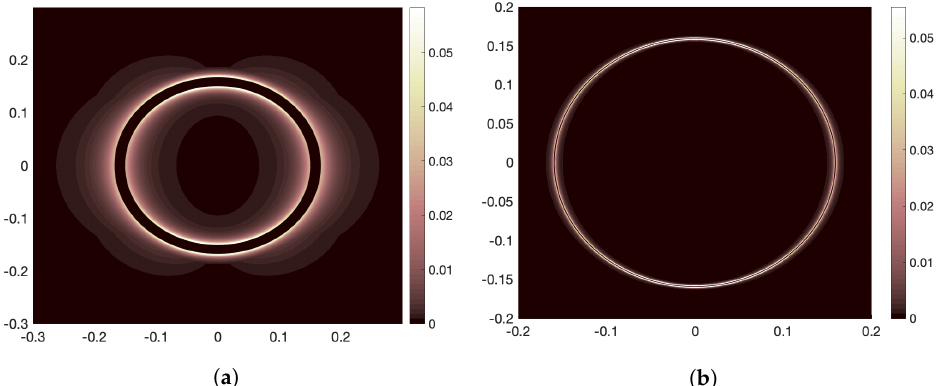
(cid:12) (cid:12) (cid:12) (cid:12) δ ( x ) − u SB ( x ) Figure 1. Plot of the difference (cid:12) u (cid:12) for x around a thin torus of length 1 with centerline in the xy -plane, subject to the forcing f = e x , for ( a ) (cid:101) = 0.01 and ( b ) (cid:101) = 0.001. The maximum difference 1 log ( 2 ) ≈ 0.05516 occurs at the fiber surface along the top and bottom of the fiber, where 4 π the force is tangent to the fiber surface. Note, however, that discrepancies extend further into the bulk on the left and right sides of the fiber, where the force is normal to the